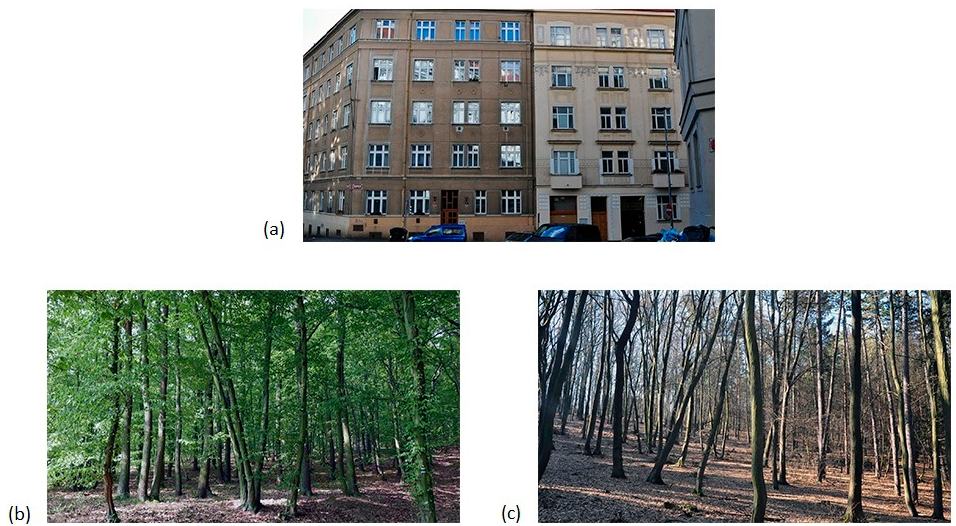
Figure 1. Examples of stimuli used in the experiment: ( a ) urban image, ( b ) forests with foliage, and ( c ) forests without foliage.